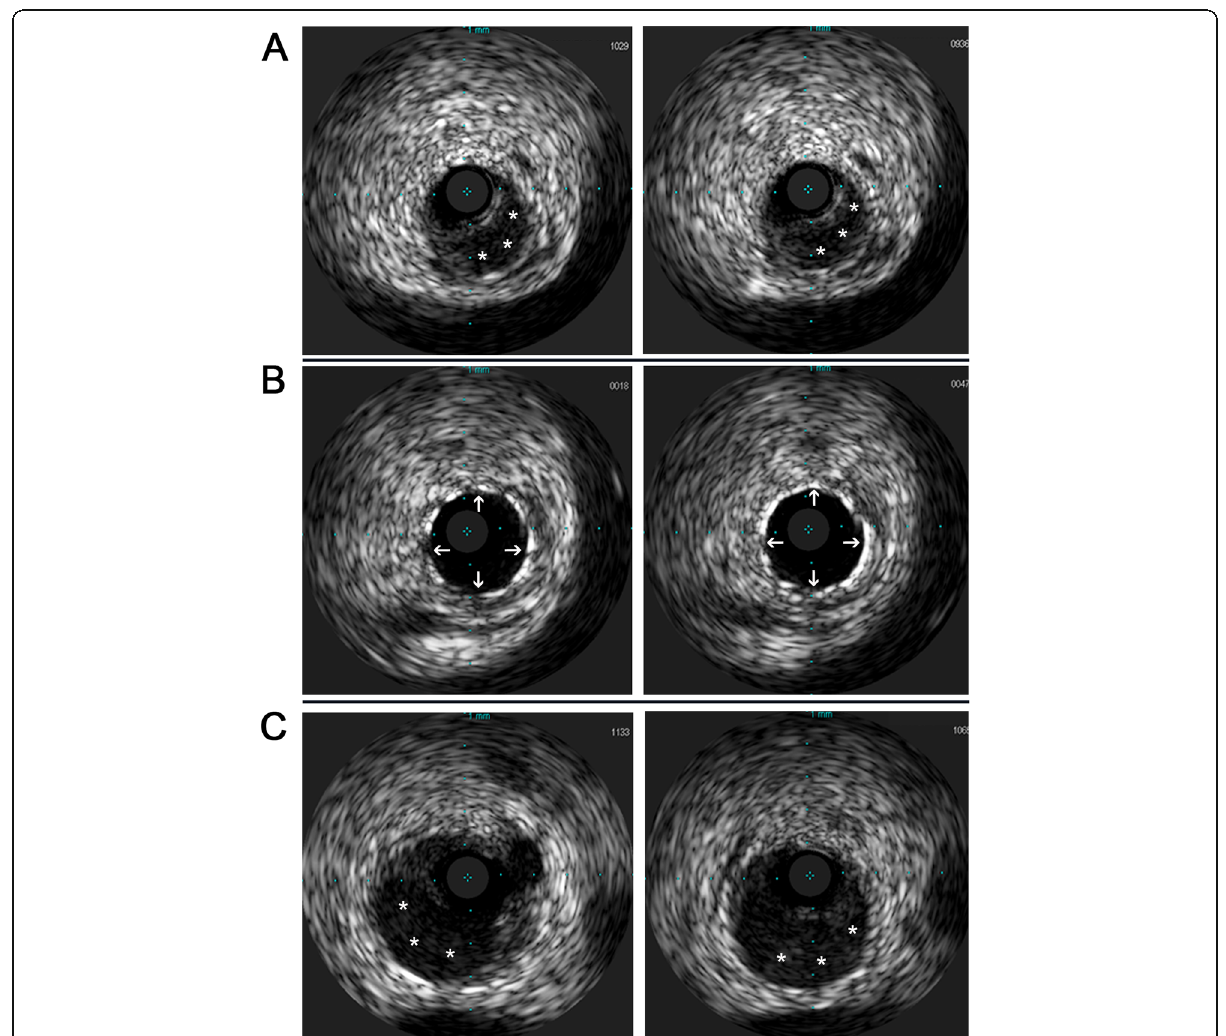
Fig. 3 a Intravascular ultrasound (IVUS) images were presented to show the artery dissection starting from the proximal right coronary artery and ascertained the guidewire passed through the true lumen properly (left and right). b IVUS demonstrated stents attached to endothelium well and covered artery dissections completely (left and right). c IVUS showed multiple focal artery dissections located at LMC, LAD, as well as the ostium and the proximal segment of LCX (left and right). The intramural hematoma was demonstrated (*), and implanted stents were indicated with